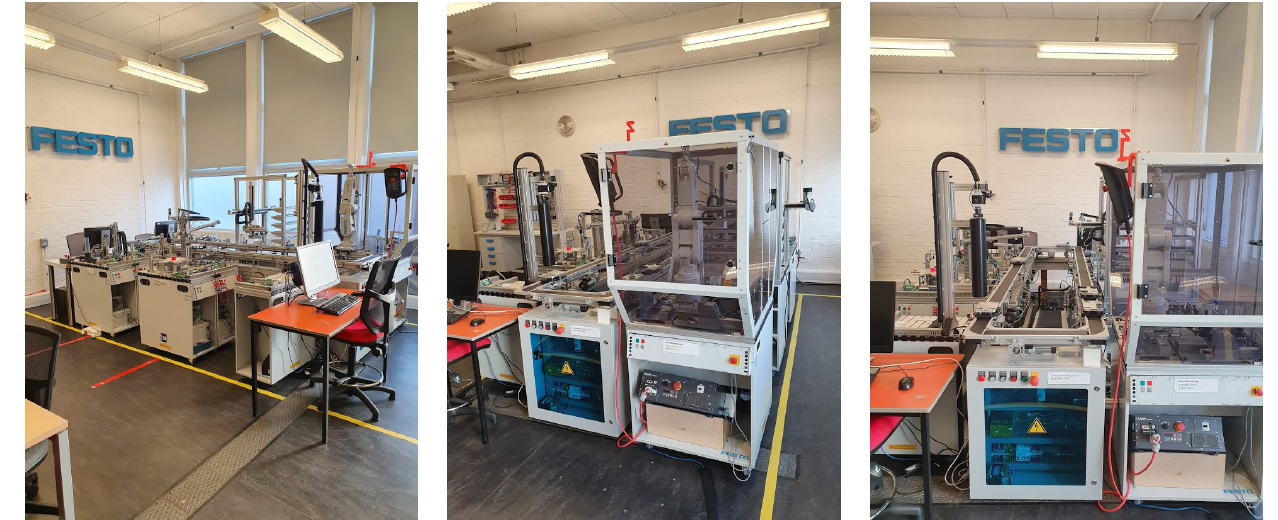
Figure 20. Scaled Flexible Manufacturing System at Edinburgh Napier